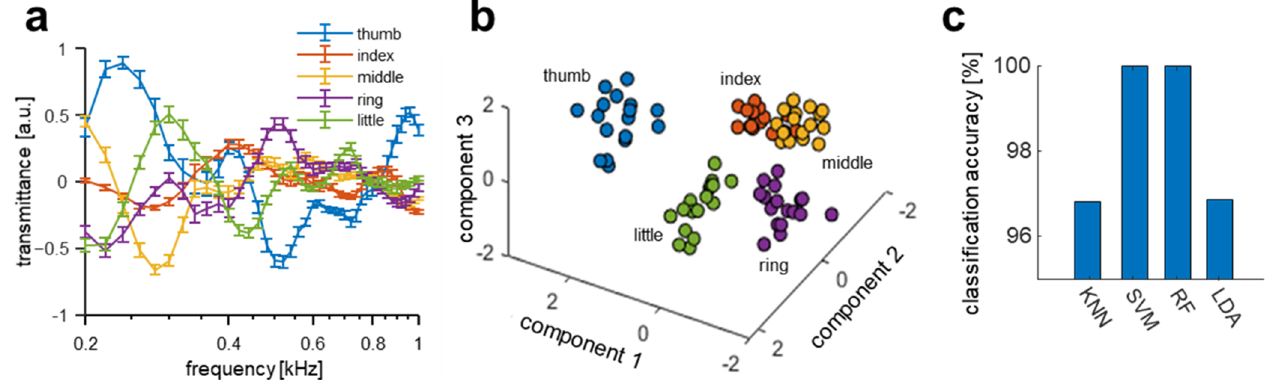
Figure 3. Acoustic spectral variations and classifications between fingers. ( a ) Acoustic spectra of each finger (thumb, index, middle, ring, and little) of a subject. The error bars in the figure indicate the relative standard deviation. ( b ) Scatter plot of the first three principal components of the acoustic spectra for each finger from principal component analysis (PCA). ( c ) Comparison of finger classification accuracy from four different classifiers.